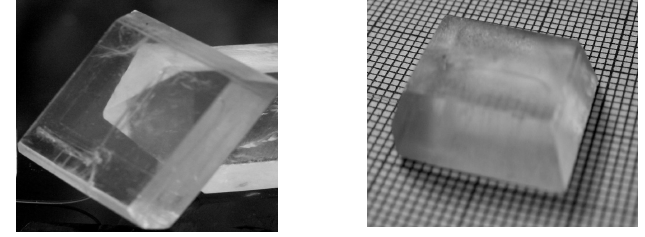
Figure 2 . Single crystal of KFCT